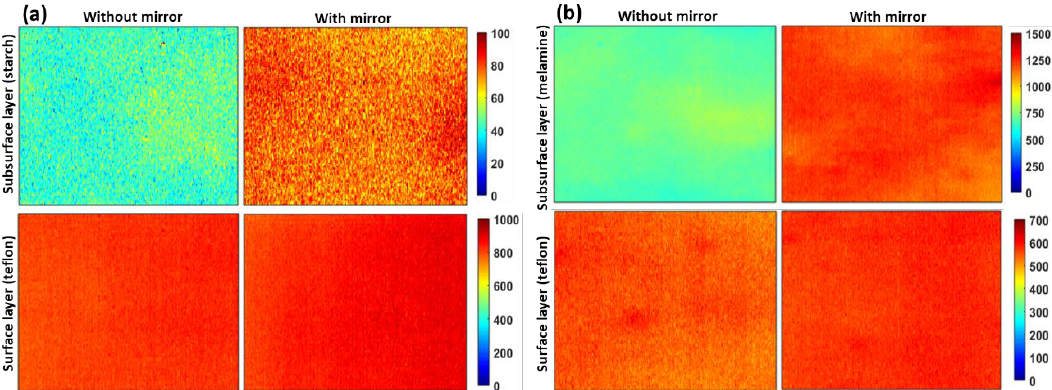
Figure 3. Preprocessed Raman band images of S1 ( a ), and S2 ( b ) for replication 1. Raman signals increase for the subsurface layer with the mirror (di ff erence between the images on upper row), however, there was no notable di ff erence in the Raman intensity of the surface layer when using the reflection mirror (bottom row). Raman maps with and without mirror are presented in the same intensity scale for the purpose of direct comparison and the intensity scales are in arbitrary